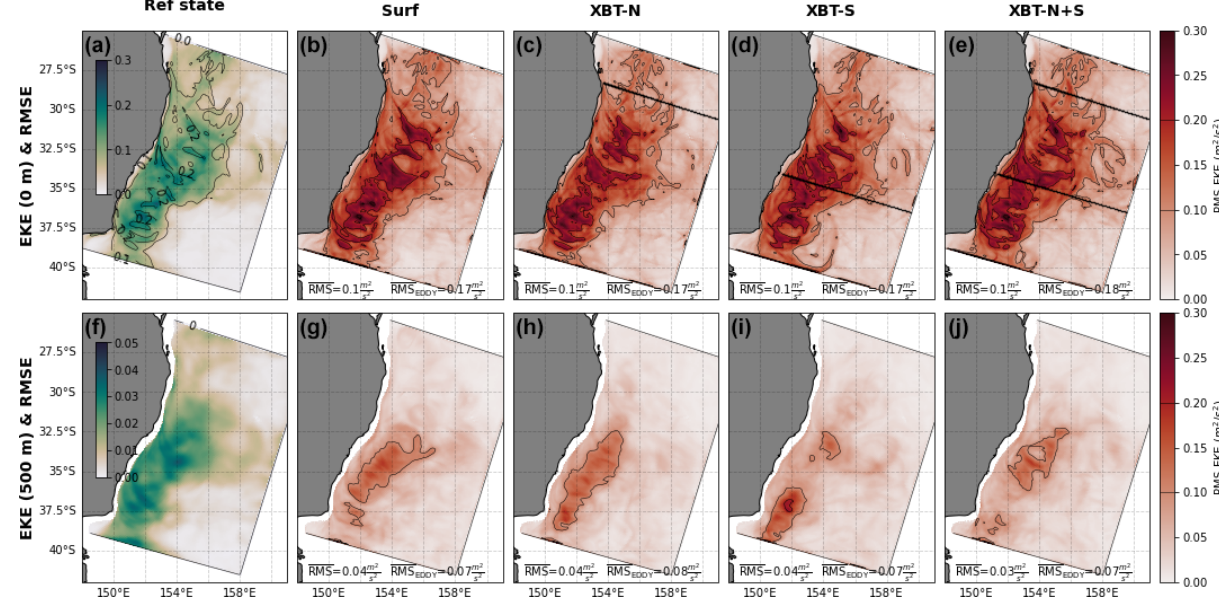
Figure B1. The differences in spatial representation of EKE between the reference state and each OSSE. (a) The time-mean surface EKE of the Reference state, with contours of standard deviation in that field. The rms error between the reference state and the OSSEs (b) surf, (c) XBT-N, (d) XBT-S, and (e) XBT-N+S. The second row (panels f–j ) shows the same fields for the EKE at 500m. Note the identical colour scales for all rms error plots. In reference state panels, contours are the standard deviation in the respective field, while in all OSSE panels, the contours are of rms error. Contour intervals are the same for all panels and are shown as a line in the rms error colour bar. Black lines in panels (c–e) indicate location of the XBT